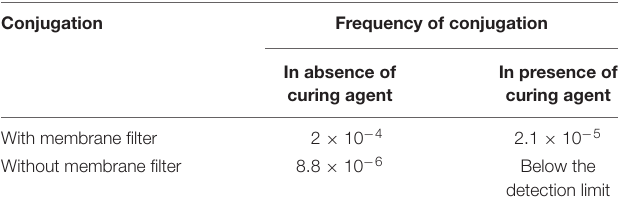
TABLE 7 | Effect of lawsone on R plasmid transfer from ampicillin resistant E. coli to streptomycin resistant E. coli by